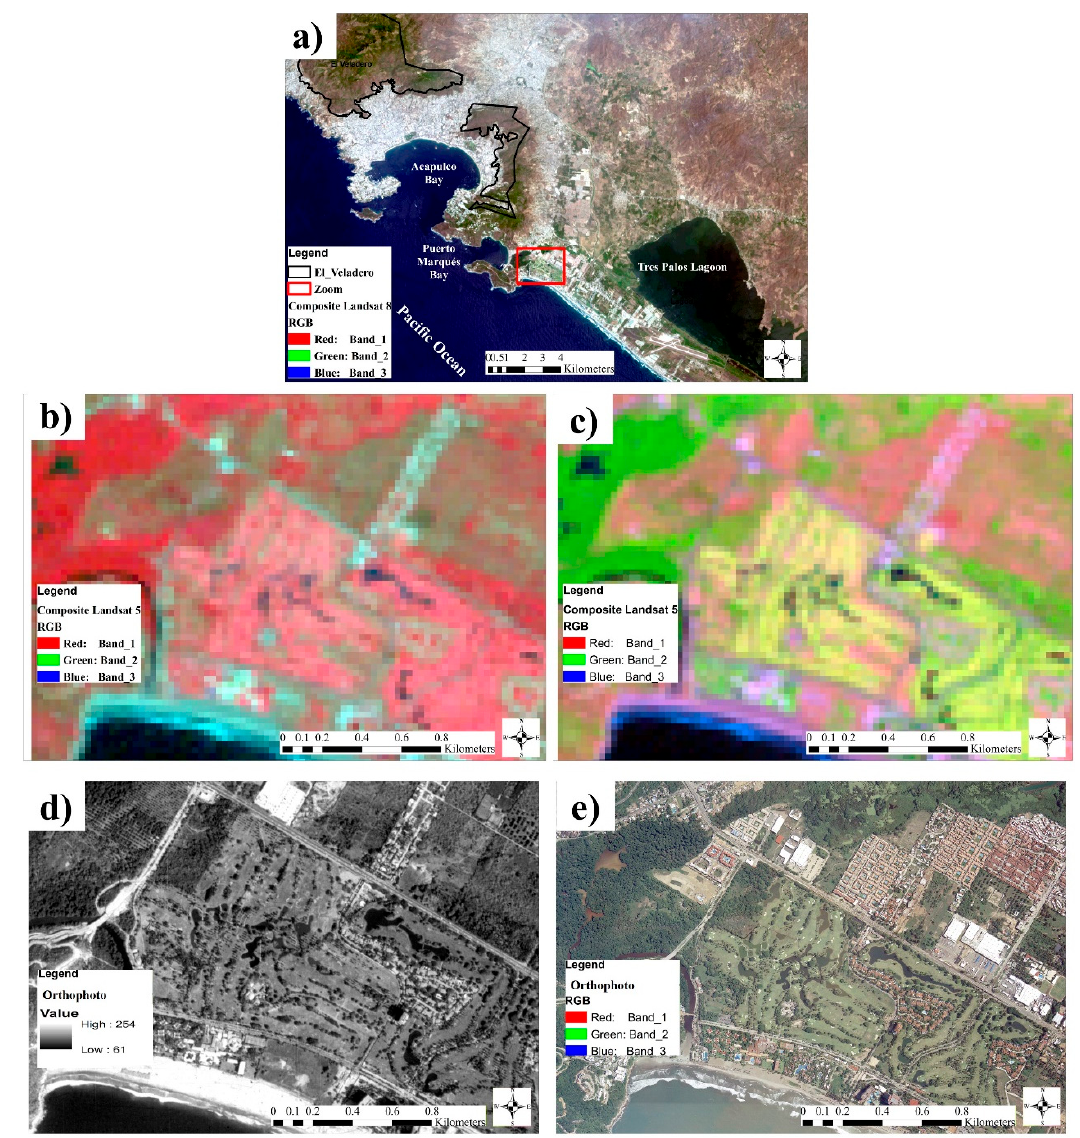
Figure 3. ( a ) True-color composite image, ( b ) Landsat 5, 1986, bands 234 at zoom, ( c ) Landsat 5, 1986, 345 at zoom, ( d ) Orthophoto 1995 1:20,000 at zoom, ( e ) Orthophoto, 2007, 1:10,000 at zoom.